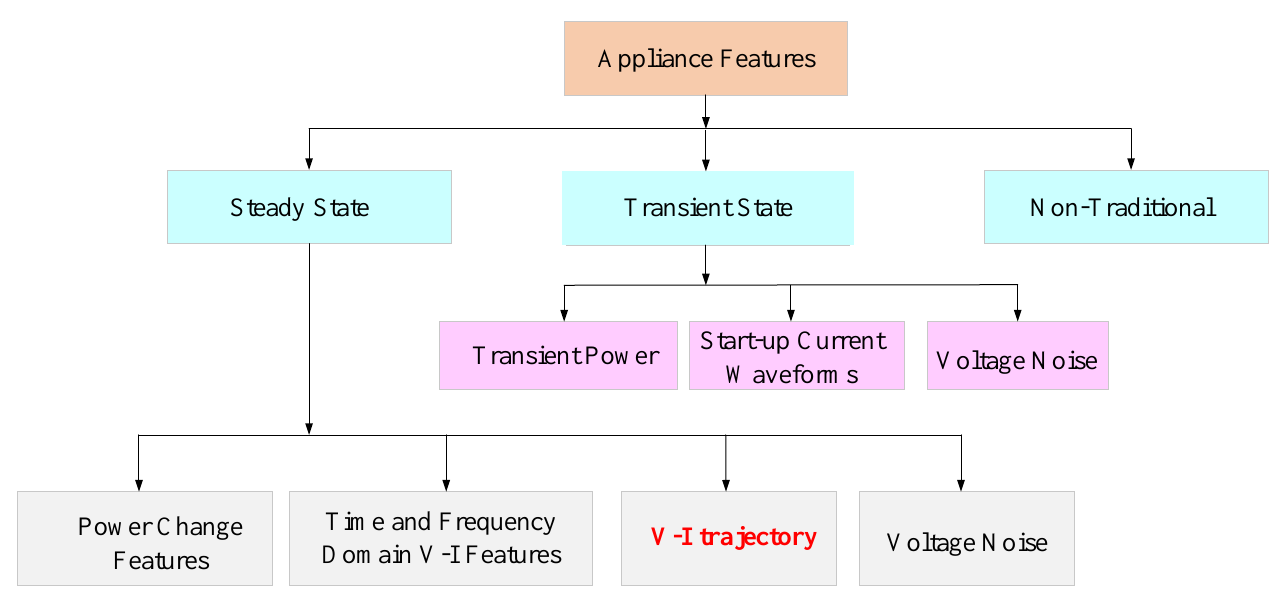
Figure 2. Taxonomy of appliance signatures for